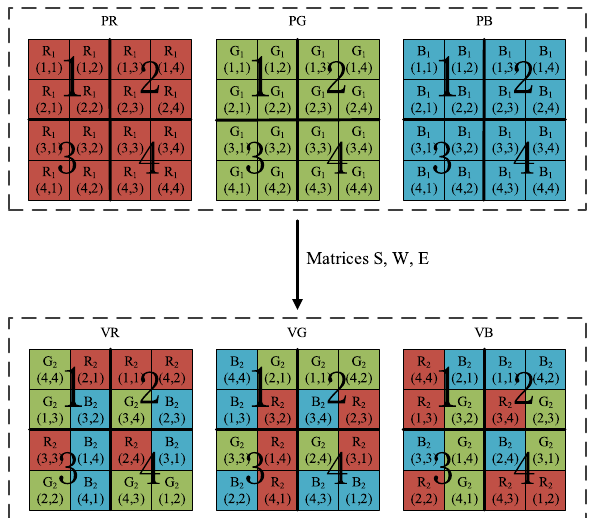
Fig. 5 Illustrationofdeterminingthetargetpositionofeachpixelmove- ment according to three matrices S , W , E shift the pixel located at the i th row and j th column